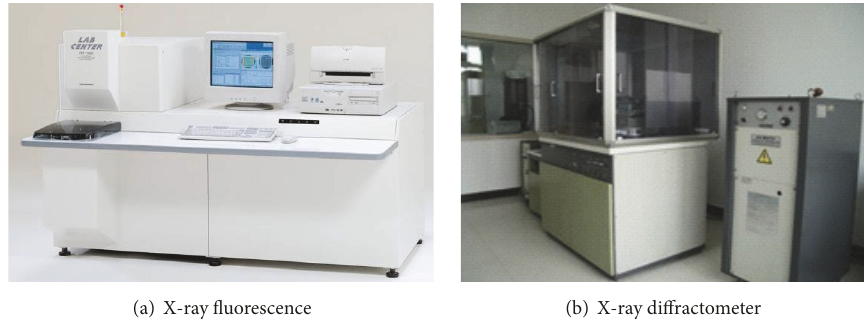
Figure 1: Composition analysis instrument.